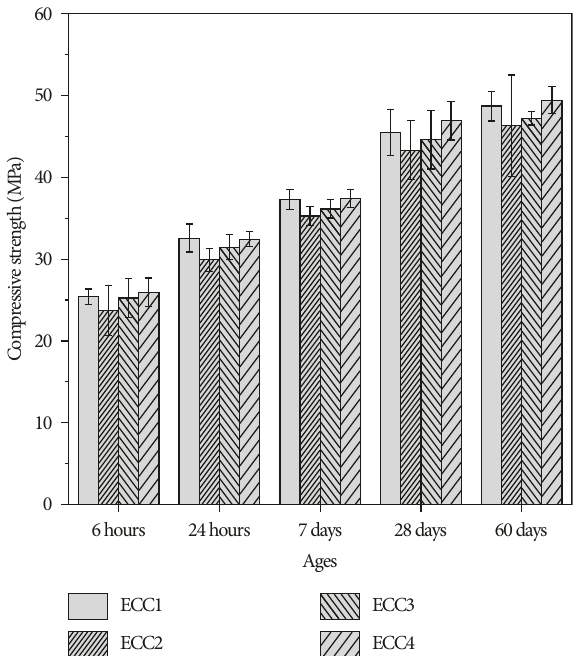
Figure 5: Compressive strength development of HES-ECC